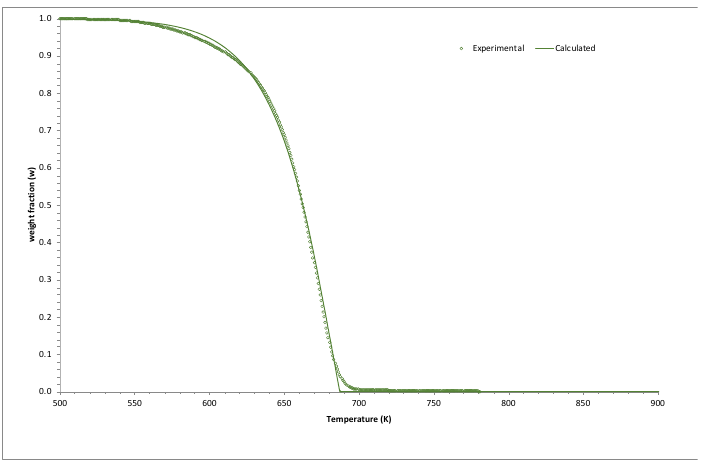
Figure 5. Thermal decomposition of PS at 10 K/min. Experimental and calculated